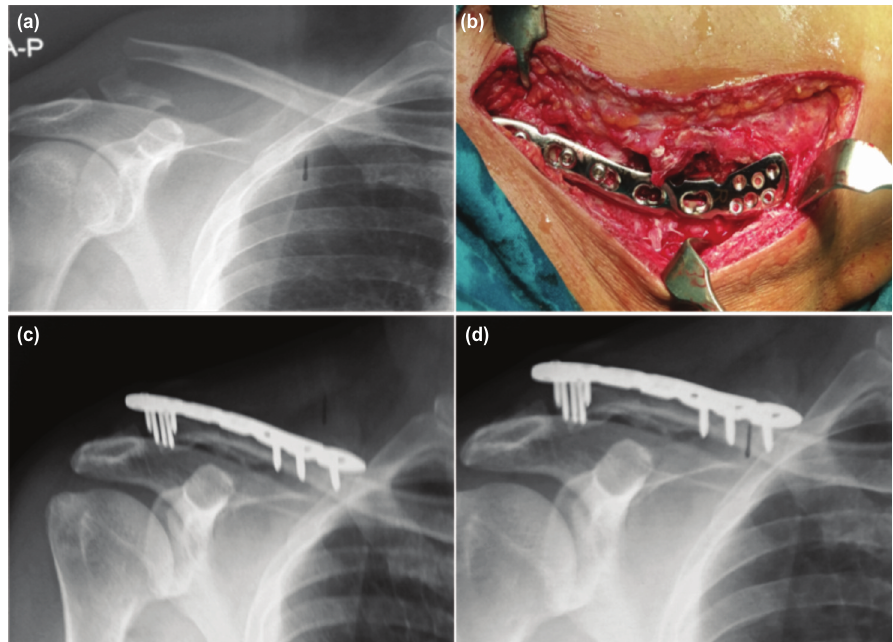
(a) Radiographs antero-posterior view of shoulder showing lateral end of clavicle fracture, (b) Intra-operative photograph after Fig. 3: fixation with pre-contoured lateral third clavicular plate. Radiographs taken at (c) 6 months and (d) 9 months after surgery showing fracture